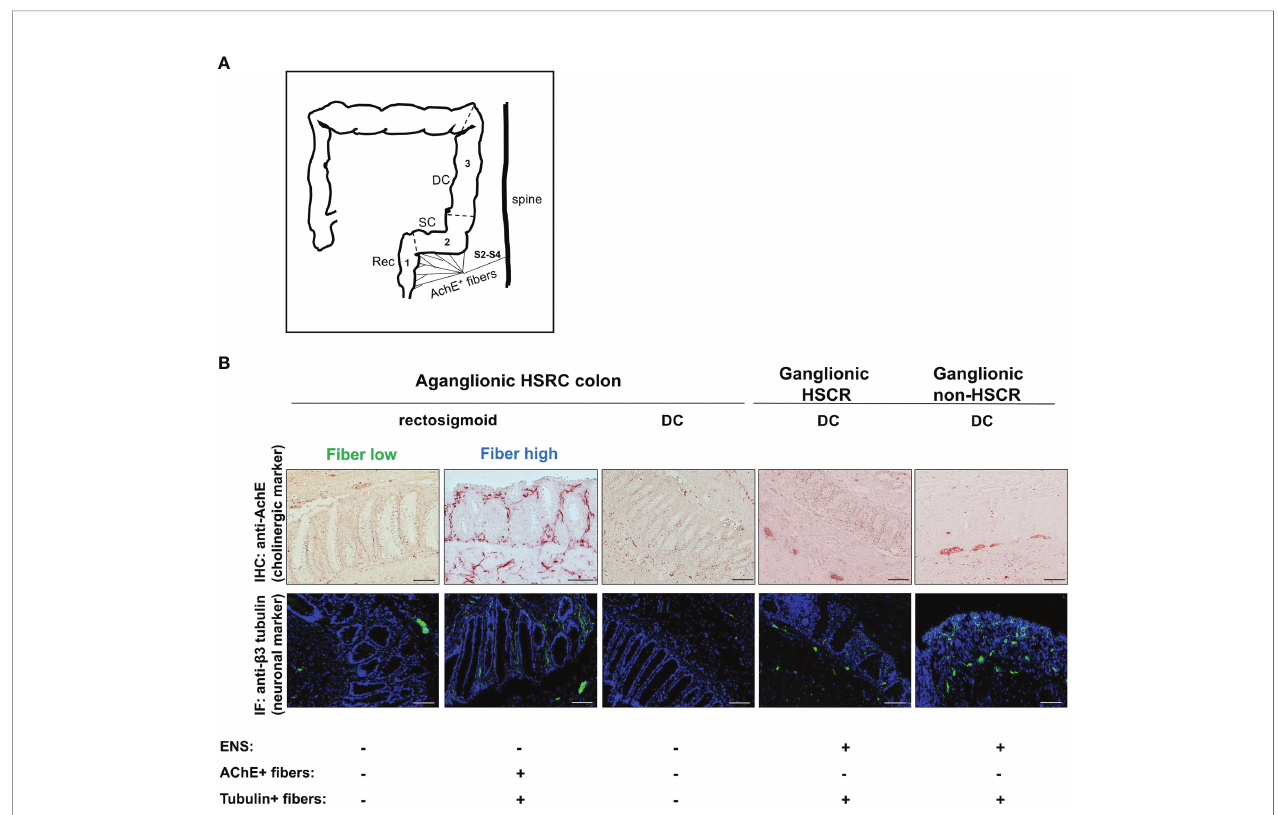
FIGURE 1 | Neuronal innervation of the lower colon track in HSCR and non-HSCR patients. Schematic representation of extrinsic AChE + nerve fi ber innervation (A) . Anatomically, extrinsic innervation derived from sacral roots S2 – 4 is limited to the rectosigmoid and does not reach the descending colon. Rec (1), rectum; SC (2), sigmoid colon; DC (3), descending colon; AChE, acetylcholinesterase; S2 – 4, sacral roots S2 – 4. Cryosections (5µm) of aganglionic and ganglionic colonic tissue from HSCR and non-HSCR patients showing anti-AChE immunohistochemistry and anti-ß3 tubulin immuno fl uorescence (B) . Five different colonic tissue types were distinguished, and each showed different expression of ENS (aganglionic versus ganglionic) and mucosal nerve fi ber innervation. Scale bar: 50µm. IHC, immunohistochemistry; IF, immuno fl uorescence; ENS, enteric nervous